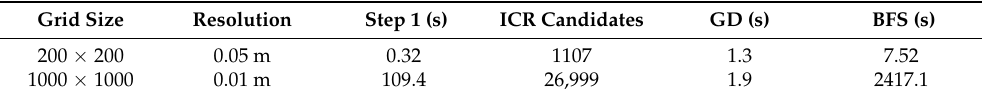
Table 2. Time for computation during optimization using gradient-descent (GD) and brute force search (BFS)